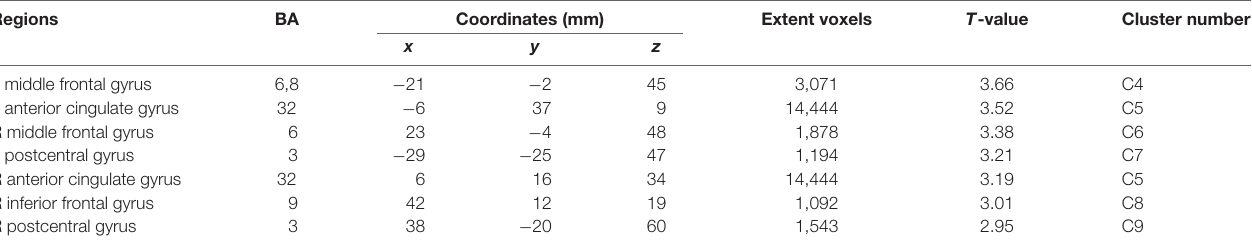
TABLE 3 | Positive correlations between regional cerebral glucose metabolism and KART-estimated FSIQ score after adjusting for age and gender in A β -negative CN subjects. Regions BA Coordinates (mm) Extent voxels T -value Cluster number x y z L middle frontal